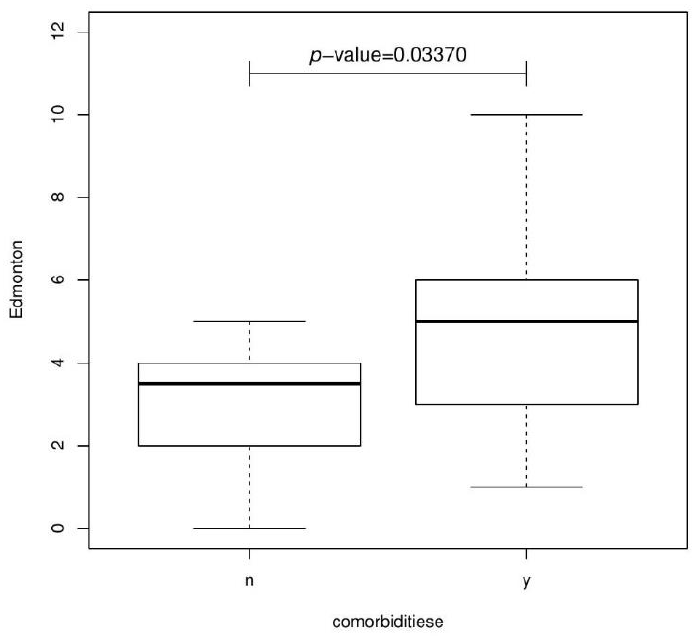
Figure 5. Boxplot presenting the relationship between Comorbidities and Edmonton. All patients with heart failure and frailty syndrome 12.3% (13 patients) were diagnosed with additional comorbidities. Of the patients, 98% (46 patients) susceptible to developing the frailty syndrome also had additional diseases. The ordinal regression model was used to determine the relationship between the groups of the Edmonton variable and dichotomous variables describing the existence of comorbidities of the studied patients. Eight models were created in which the dependent variable were groups of the Edmonton variable and the independent variable was one of the eight comorbidities listed in Table 1. The coefficients of the model are statistically significant only for the variable ‘chronic kidney disease’ ( p -value = 0.00004). The odds ratio OR = 6.6423 was determined using the value of the coefficient for the variable ‘chronic kidney disease’ (1.8935). The obtained result indicates that the odds that a person suffering from chronic kidney disease will be in the group with higher values of the Edmonton variable is over 6.6 times higher than for patients who do not suffer from the above-mentioned disease. The predicted probability